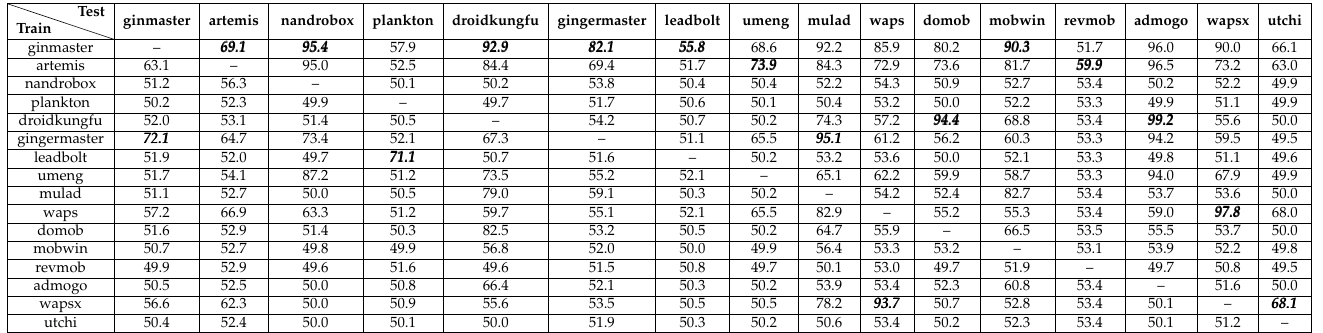
Table 3. Malware detection performance with different malware families in the training set using csbd. The number in bolds show the best results.